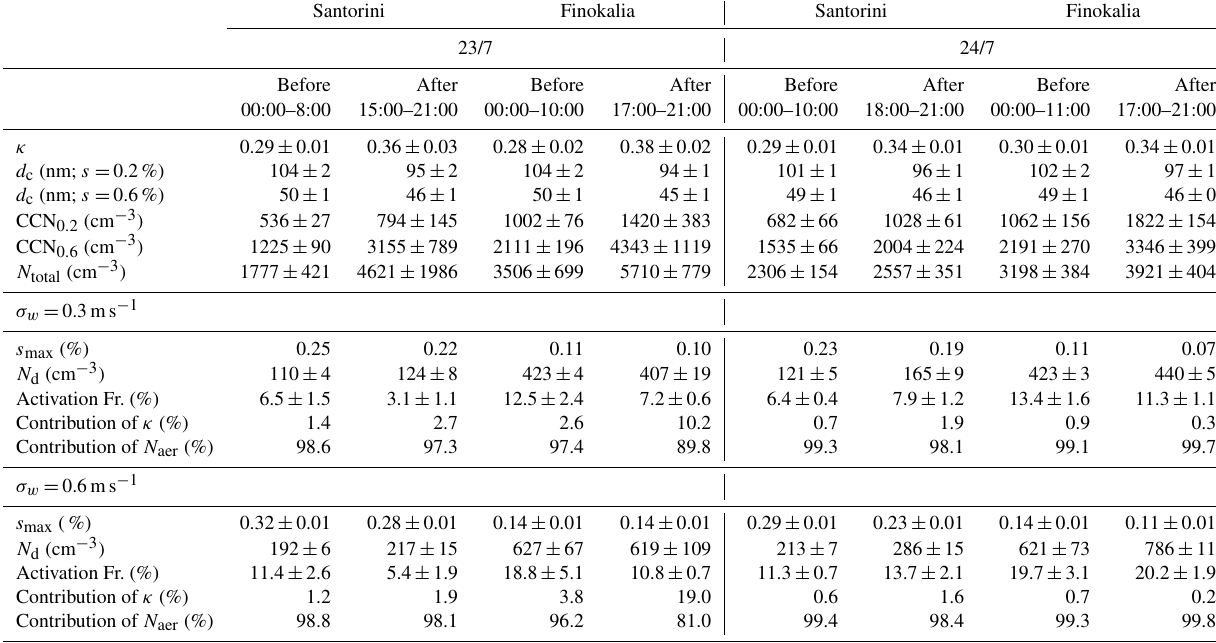
Table 3. Average ( ± standard deviation) of calculated κ using the PM 1 chemical composition at Finokalia, the d c (as described in the text), and the estimated CCN concentration particles at both stations on 23 and 24 July (EF period). Here s max is the maximum supersaturation in the cloud, N total is the total particle number concentration, and N d is the potential cloud droplet number concentration calculated according to the approach described in the main text. Two probability density functions (PDFs) of the characteristic updraft velocity are used with σ w = 0.3ms − 1 and σ w = 0.6ms − 1 . Time is in LST.